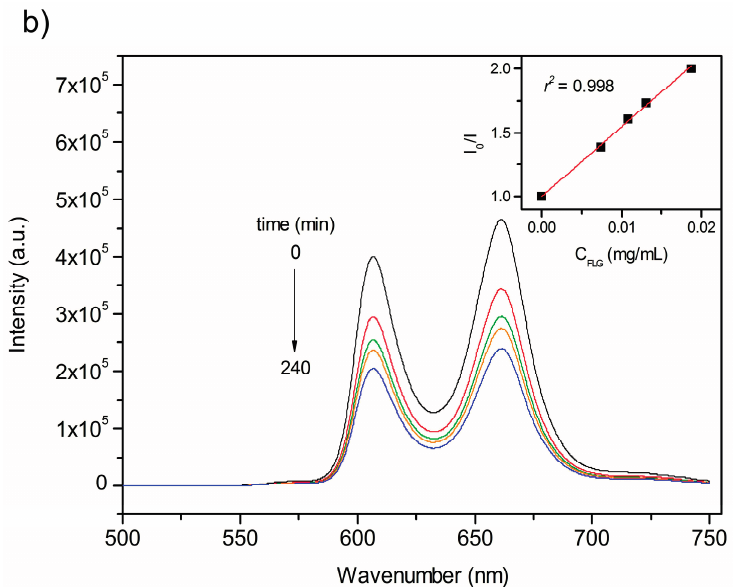
Figure 4. Fluorescence emission spectra of nanographene/porphyrin hybrids recorded at different exfoliation times of graphene ( a ) FLG/DMPP ( λ exc = 418 nm); and ( b ) FLG/ZnDMPP ( λ exc = 427 nm). The insets are the Stern-Volmer plots of I 0 / I vs. C FLG for FLG/DMPP (recorded at λ = 650 nm) and FLG/ZnDMPP (recorded at λ = 606